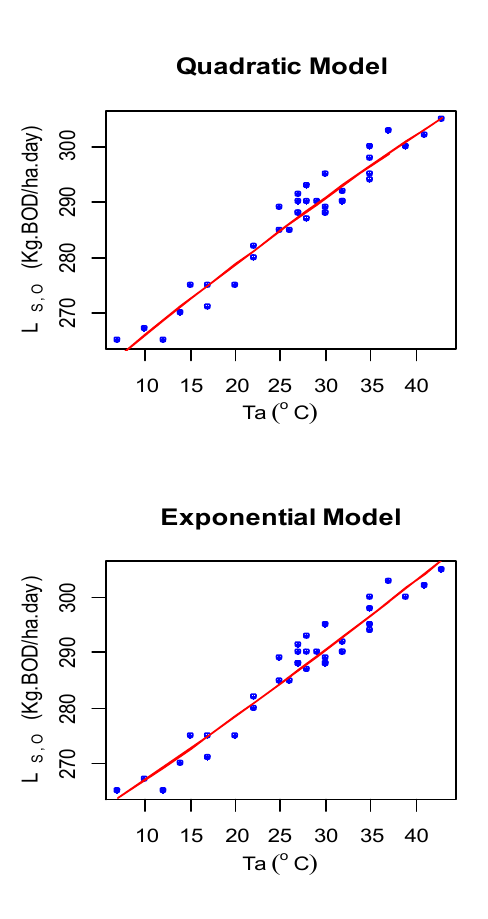
Fig. 4. Linear and nonlinear